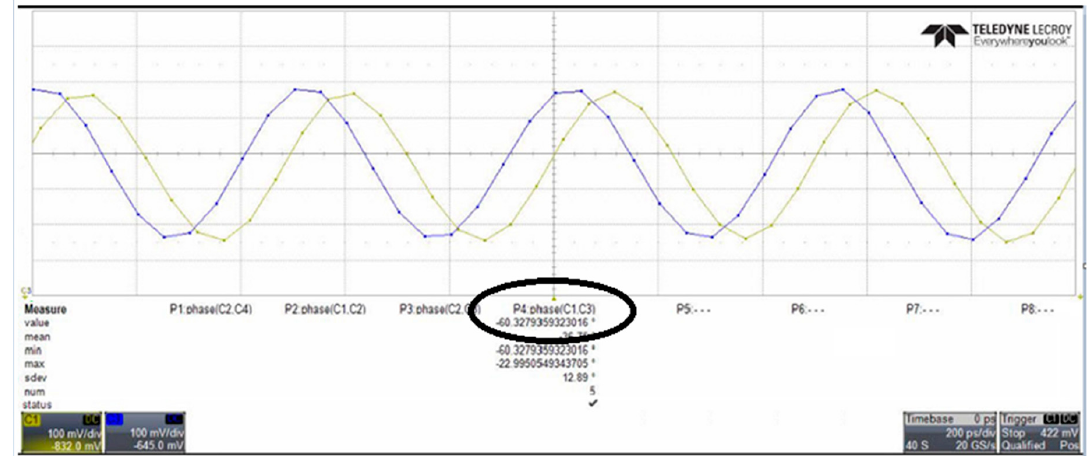
Figure 10. A 60.32° phase shift occurs between the two output signals.